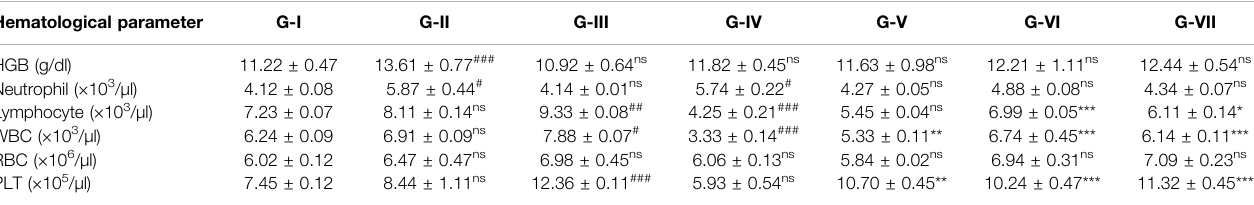
TABLE 3 | Effect of polyherbal combination on hematological parameters of mice after the end of treatment. Hematological